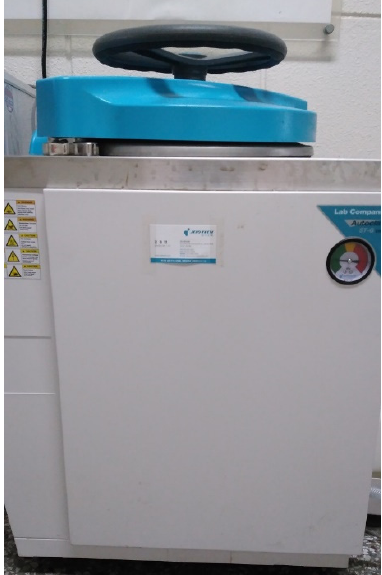
Figure 9. Image of the conventional pretreatment equipment (Autoclave).